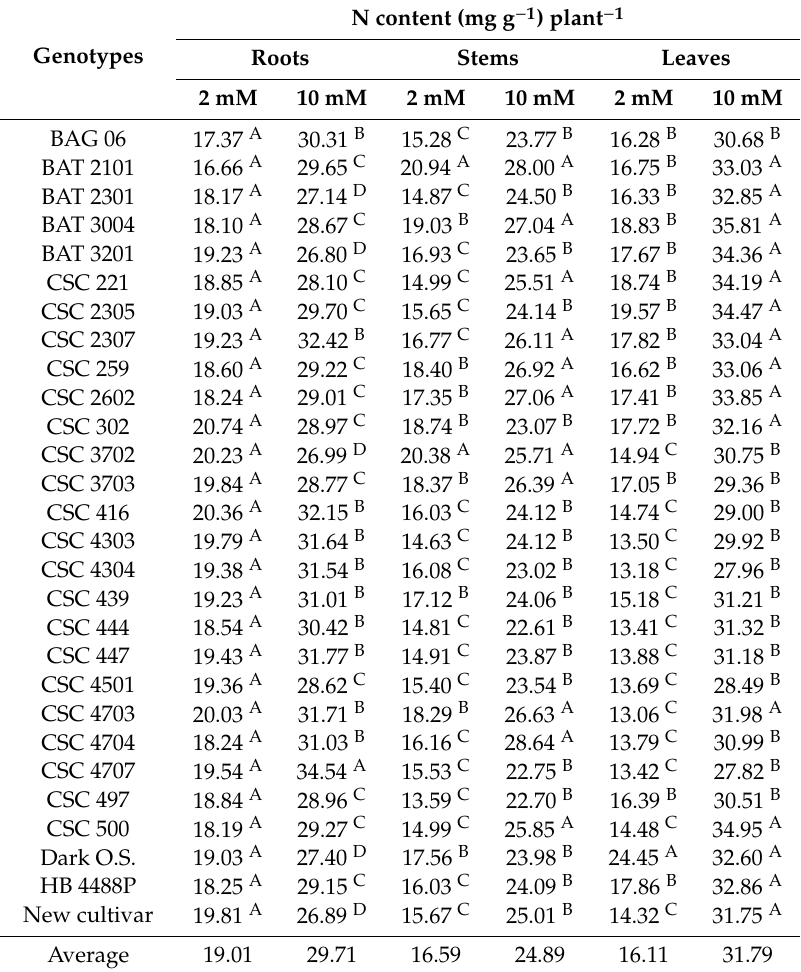
Table 2. Means of N content (mg g − 1 ) in the roots, stems, and leaves of 28 genotypes of tobacco grown at 2 and 10 mM of